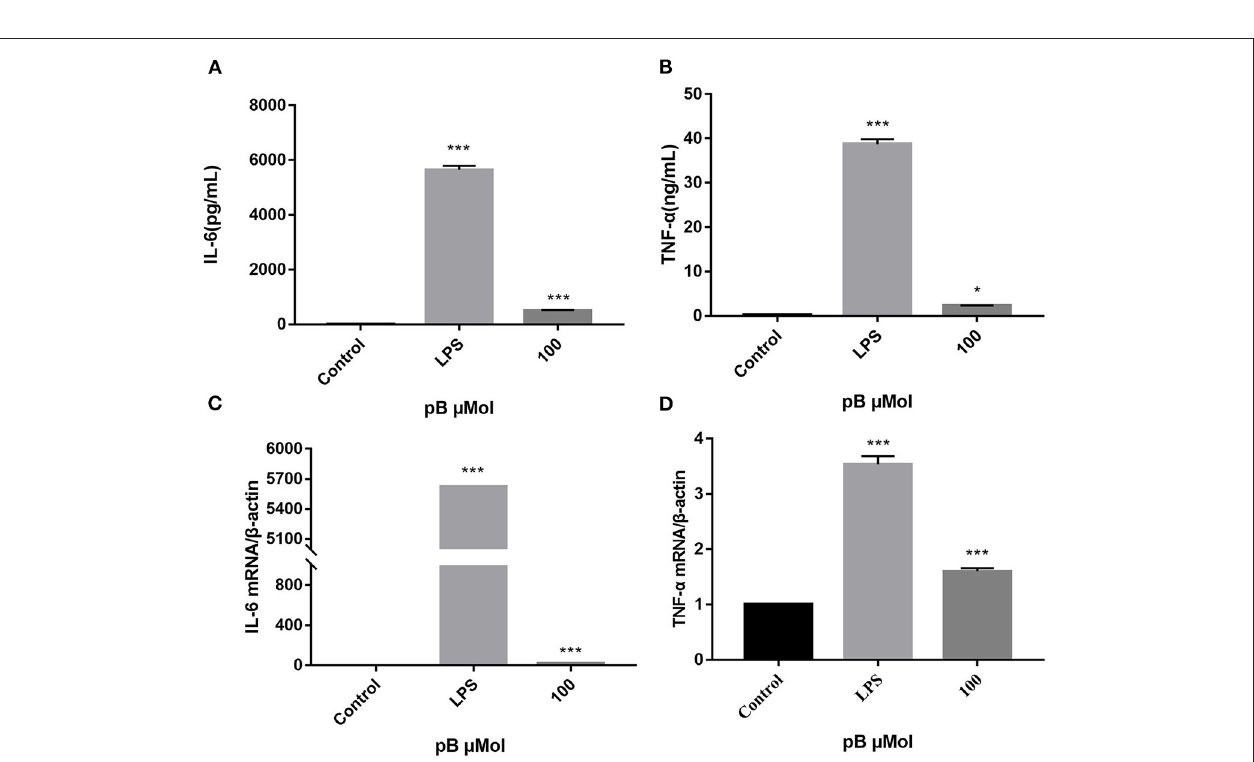
FIGURE 4 | The effects of pB on the expression of IL-6 (A) , tumor necrosis factor- α (TNF- α ) (B) , interleukin-6 (IL-6) (C) , and TNF- α (D) mRNA in Raw264.7 cells. Data presented are the mean ± SD, n = 3. Compared with the control, *** p < 0.001 and * p <